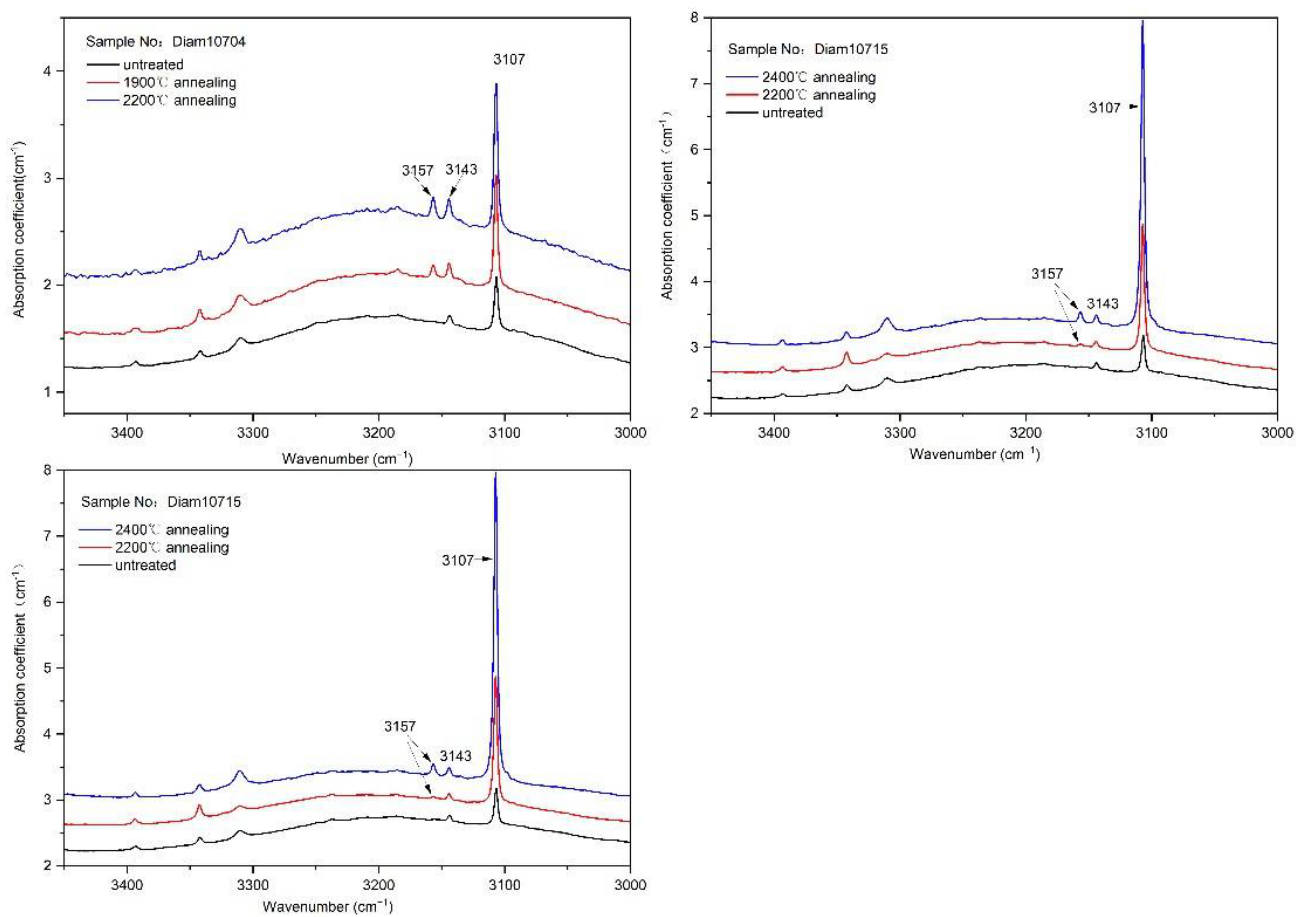
Figure 7. The absorption difference in the infrared region before and after HPHT-treated natural diamonds.